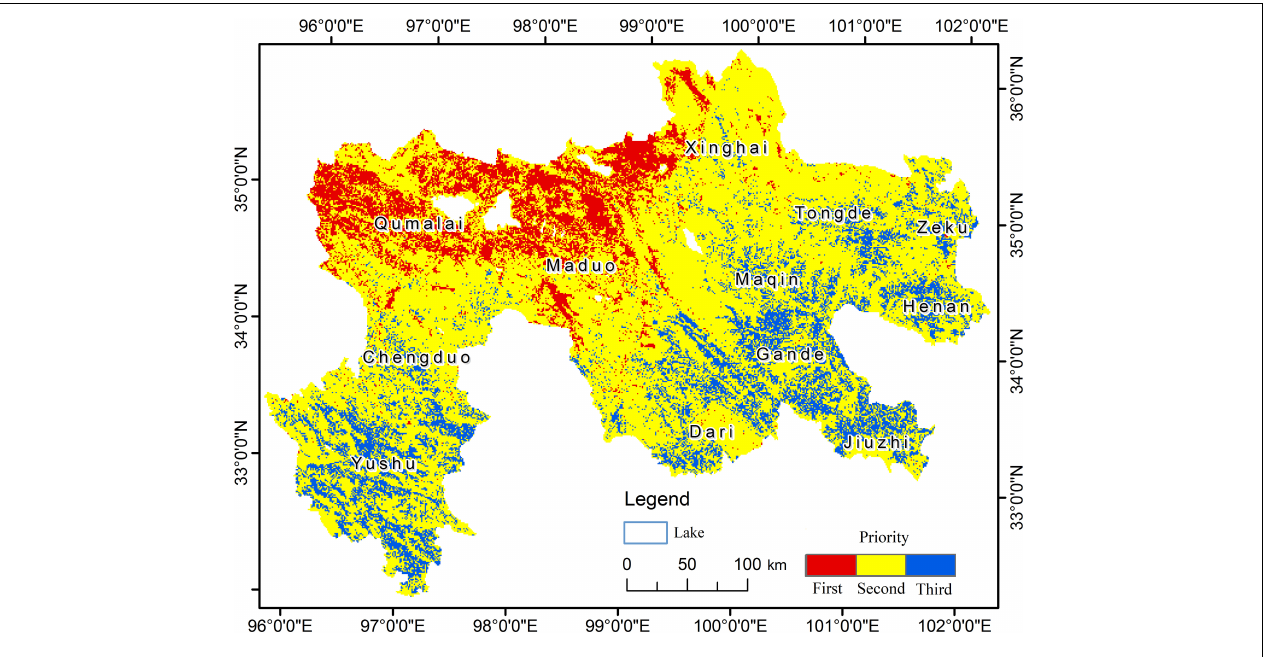
FIGURE 6 | Priority level of soil erosion control